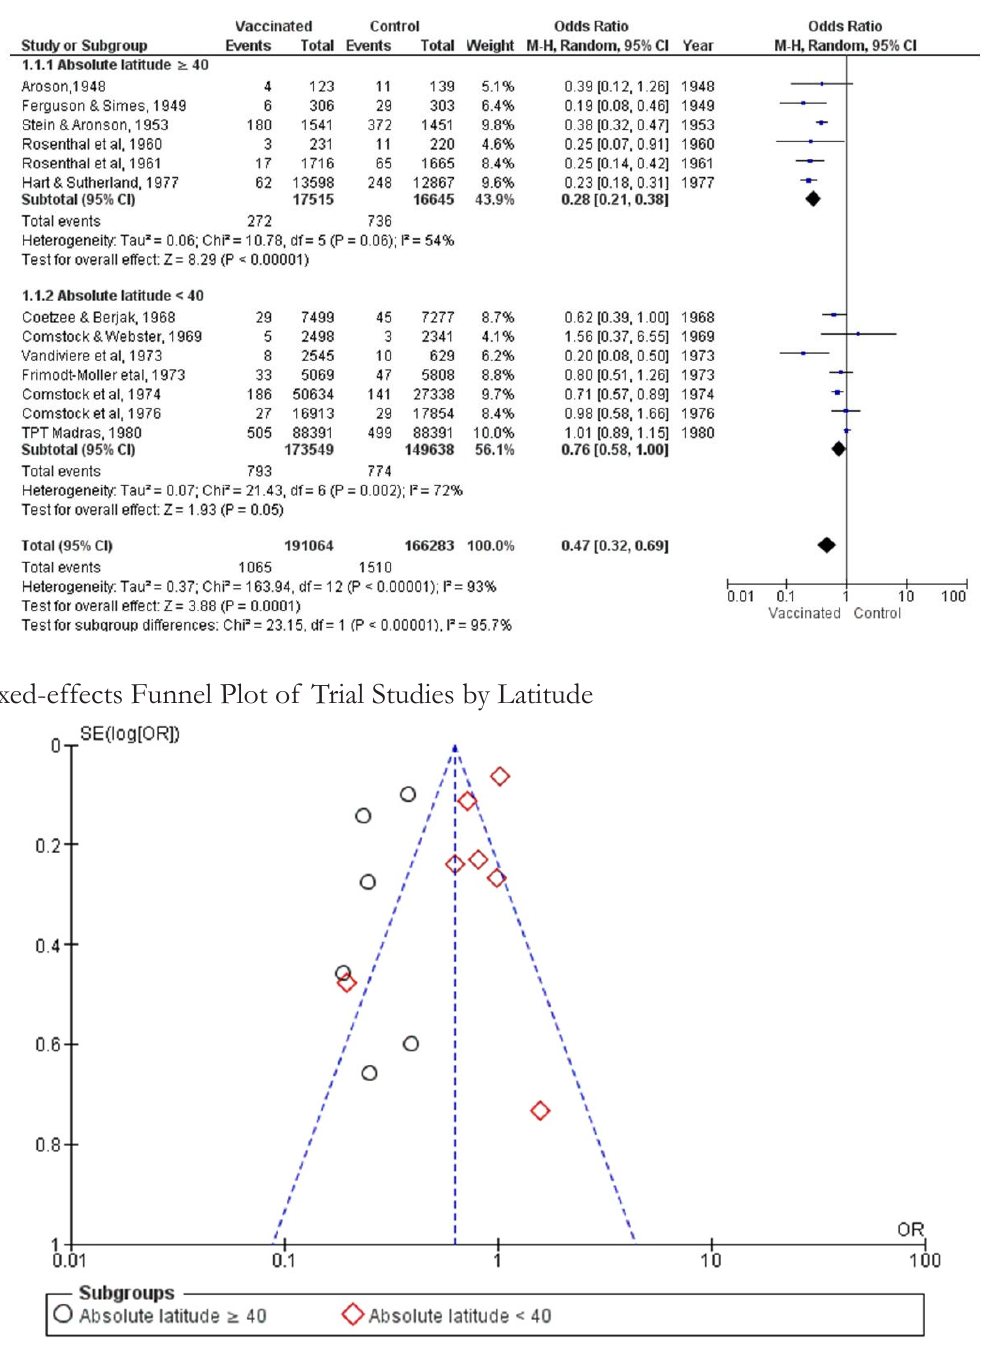
Figure 1. Forest Plot - Fixed-effects Model